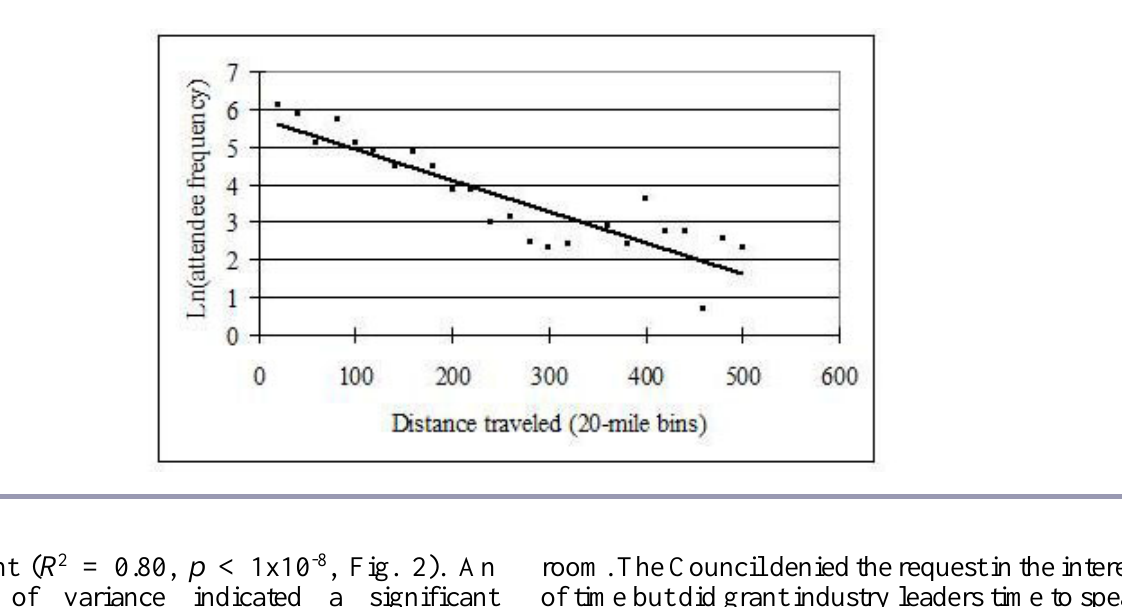
Fig. 2. Linear regression of the frequency of attendee distances traveled ( p <